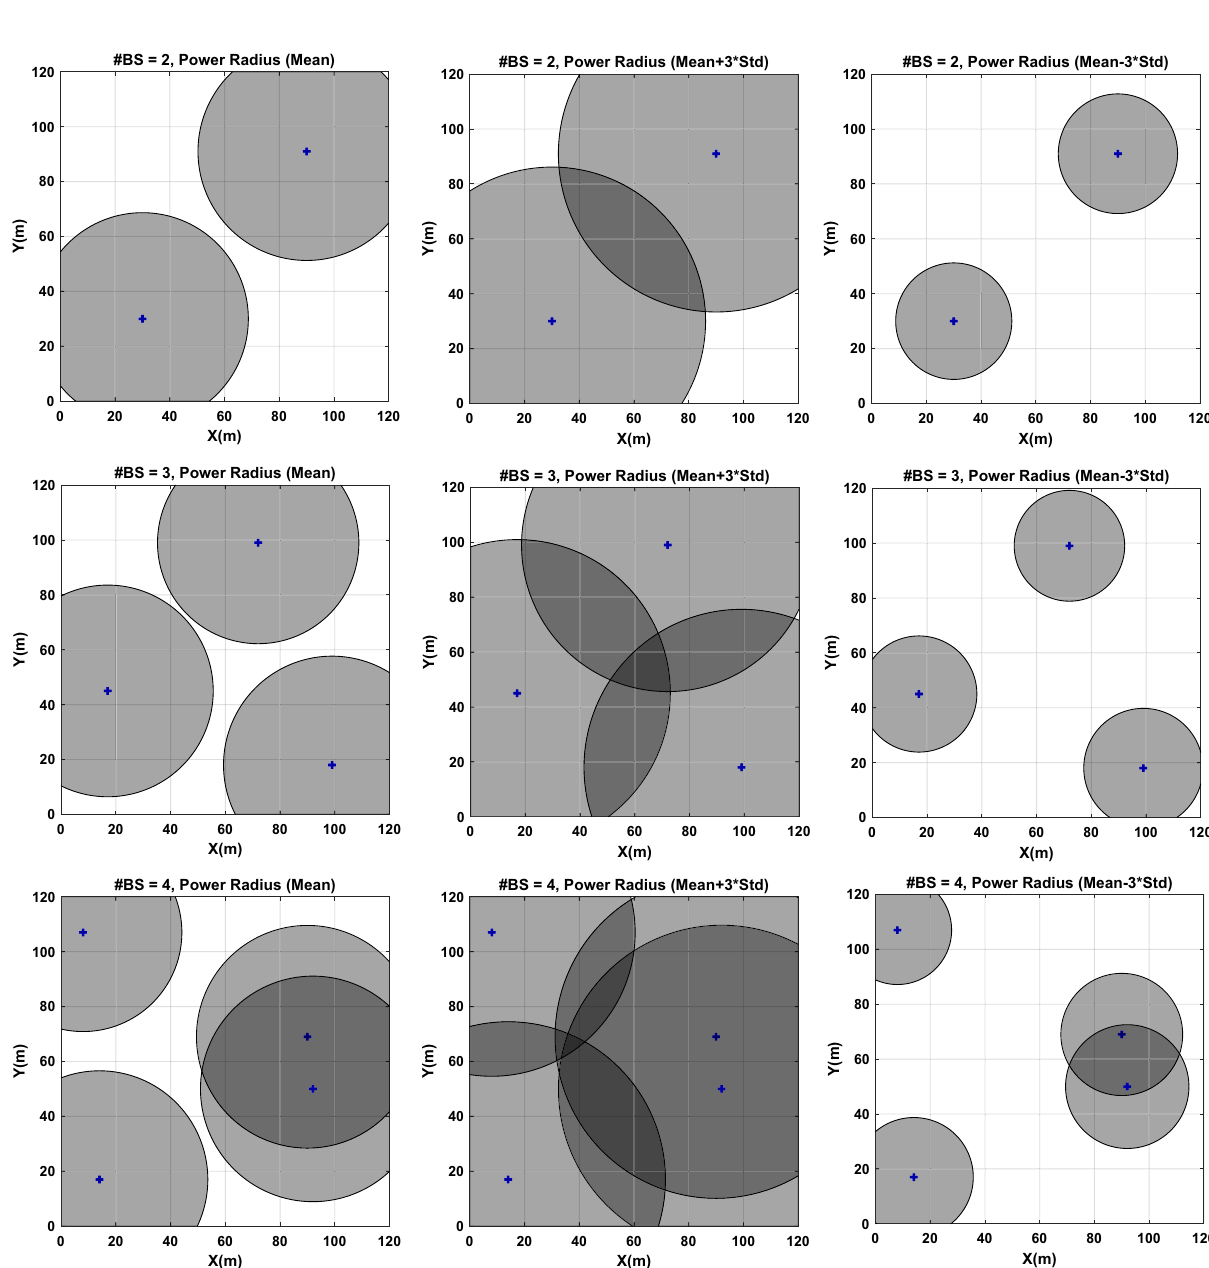
Figure 9. 2D Visualization of the robust optimal coverage for the problems with placement of two, three, and four transmitters. Shown are the mean, mean + 3 Std , and mean − 3 Std